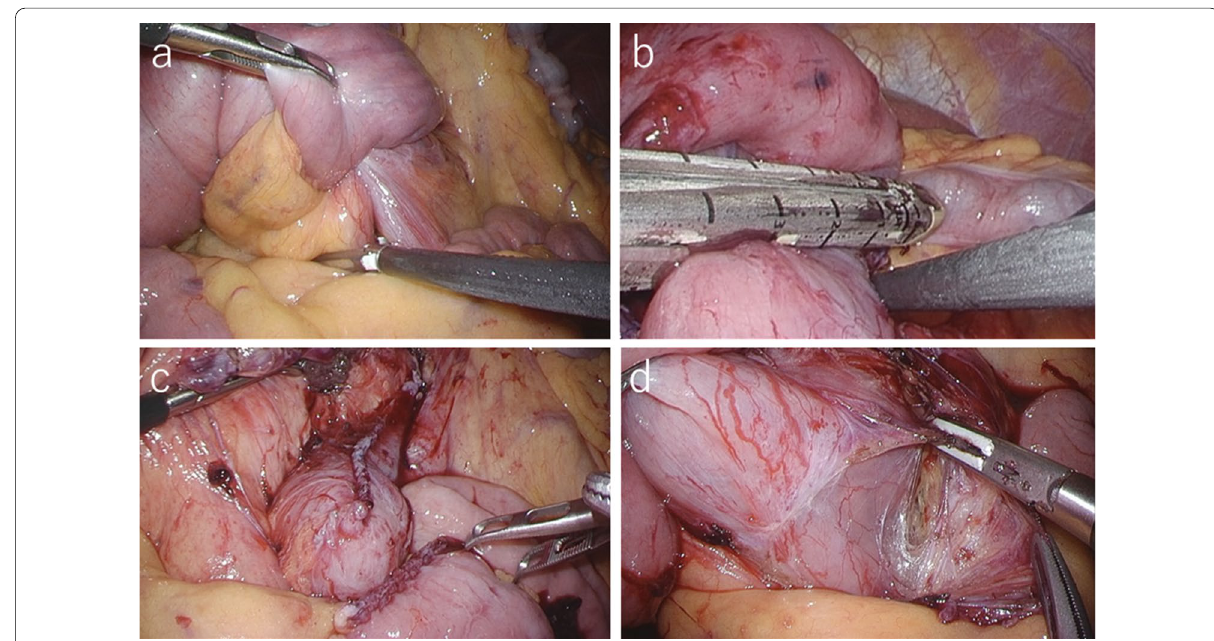
Fig. 3 Intraoperative findings. a Intestinal intussusception was seen at the angle of Treitz. b Transection line of the proximal jejunum extended from the posterior wall to the anterior wall. c After resection of the tumor, the residual duodenal stump was short. d Proximal jejunal stump was mobilized from the